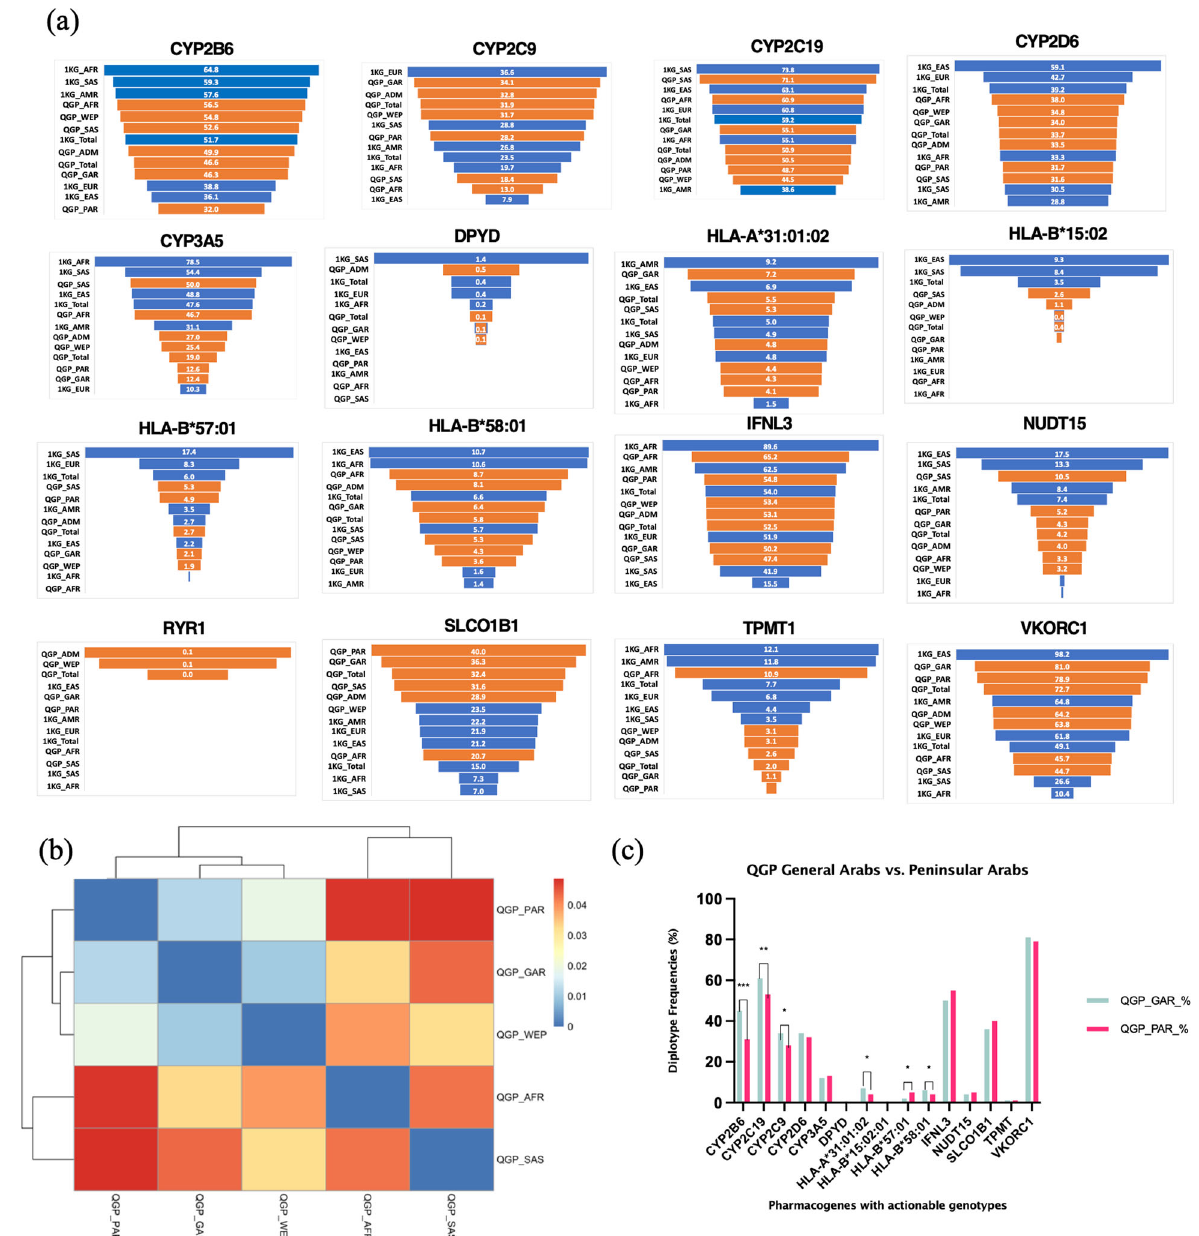
Fig. 2 Actionable genotype or diplotype frequencies in the Qatari subpopulations. ( a ) Actionable genotype/diplotype frequencies of clinically important pharmacogenes in the Qatari population and subpopulations (shown as orange bars) along with that of the overall 1000 genomes and the superpopulations (shown as blue bars). ( b ) Clustering of QGP subpopulations based on F ST calculated from the pharmacogenes. ( c ) Comparison of the actionable frequencies of QGP General Arab and Peninsular Arab subgroups. QGP subpopulations PAR, Peninsular Arabs; GAR, General Arabs; ADM, Admixed; WEP, West Eurasian/Persian; AFR: African; SAS, South Asian; 1KG, thousand genomes superpopulations: EUR, European; AMR, American; AFR: African; SAS, South Asian; EAS, East